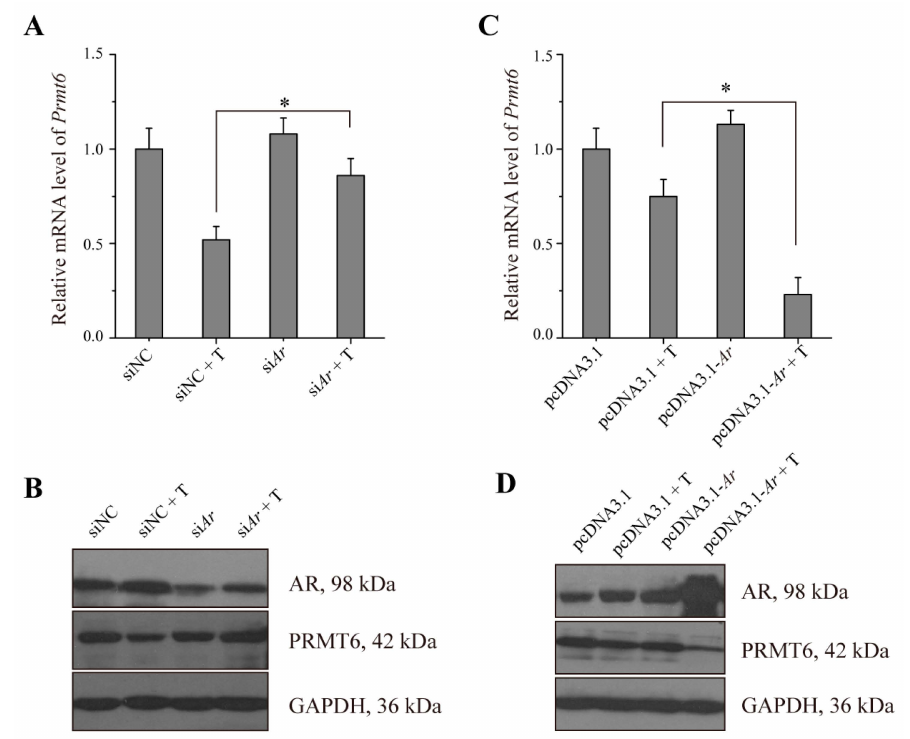
Figure 5. The expression of Prmt6 mRNA and PRMT6 protein were down-regulated by AR in TM4 cells. ( A , B ) TM4 cells were transiently transfected with siNC or si Ar , and treated with or without 10 nM testosterone (T), then the expression of Prmt6 mRNA and PRMT6 or AR protein were detected by RT-qPCR and western blotting, respectively. All of the experiments were repeated at least three times. Data are expressed as the mean ˘ SD. * p < 0.05; ( C , D ) TM4 cells were transiently transfected with pcDNA3.1 or pcDNA3.1- Ar plasmid and treated with or without 10 nM testosterone. RT-qPCR and western blotting were used to examine the expression of Prmt6 mRNA and PRMT6 or AR protein, respectively. All of the experiments were repeated at least three times. Data are expressed as the mean ˘ SD. * p <